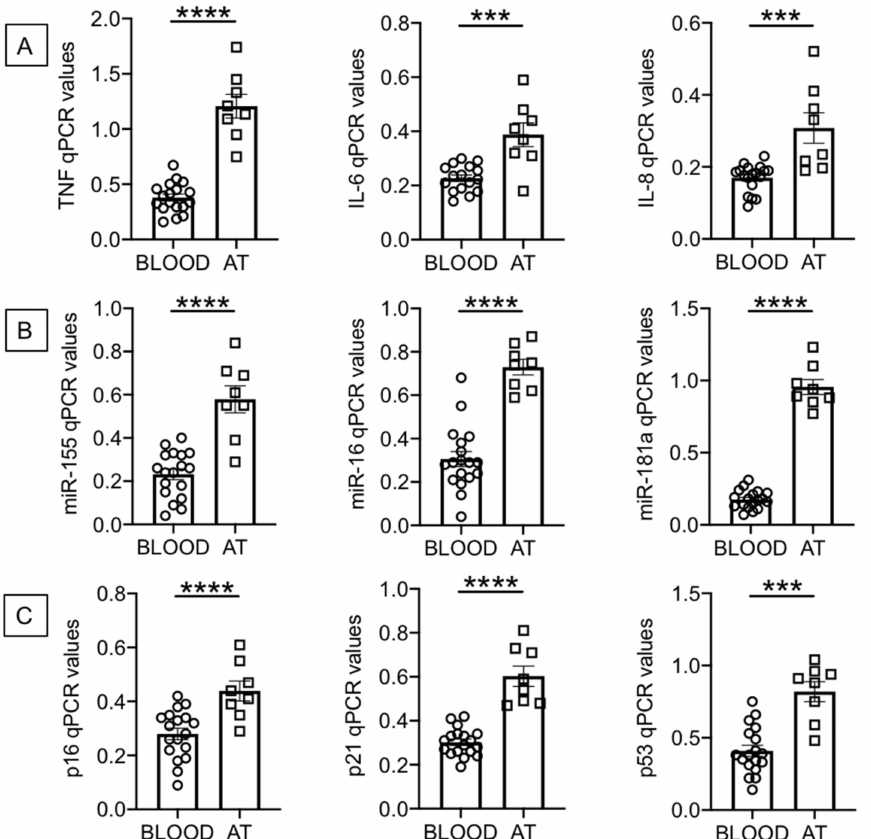
Figure 1. Increased expression of senescence-associated secretory phenotype (SASP) markers in B cells from the adipose tissue (AT), as compared to those from the peripheral blood, of individuals with obesity. B cells isolated from peripheral blood mononuclear cells (PBMC) and stromal vascular fraction (SVF) were resuspended in TRIzol, then the RNA was extracted and the expression of SASP markers detected by qPCR to evaluate expression of RNA for pro-inflammatory cytokines and chemokines ( A ), pro-inflammatory miRs ( B ), and cell cycle regulators p16 INK4 , p21 CIP1/WAF1 and p53 ( C ). qPCR values are measures of RNA expression of target genes, relative to the housekeeping genes GAPDH or U6 (for miRs quantification), calculated as 2 − ∆ Cts . Mean comparisons between groups were performed by unpaired Student’s t test (two-tailed). *** p < 0.001, **** p <